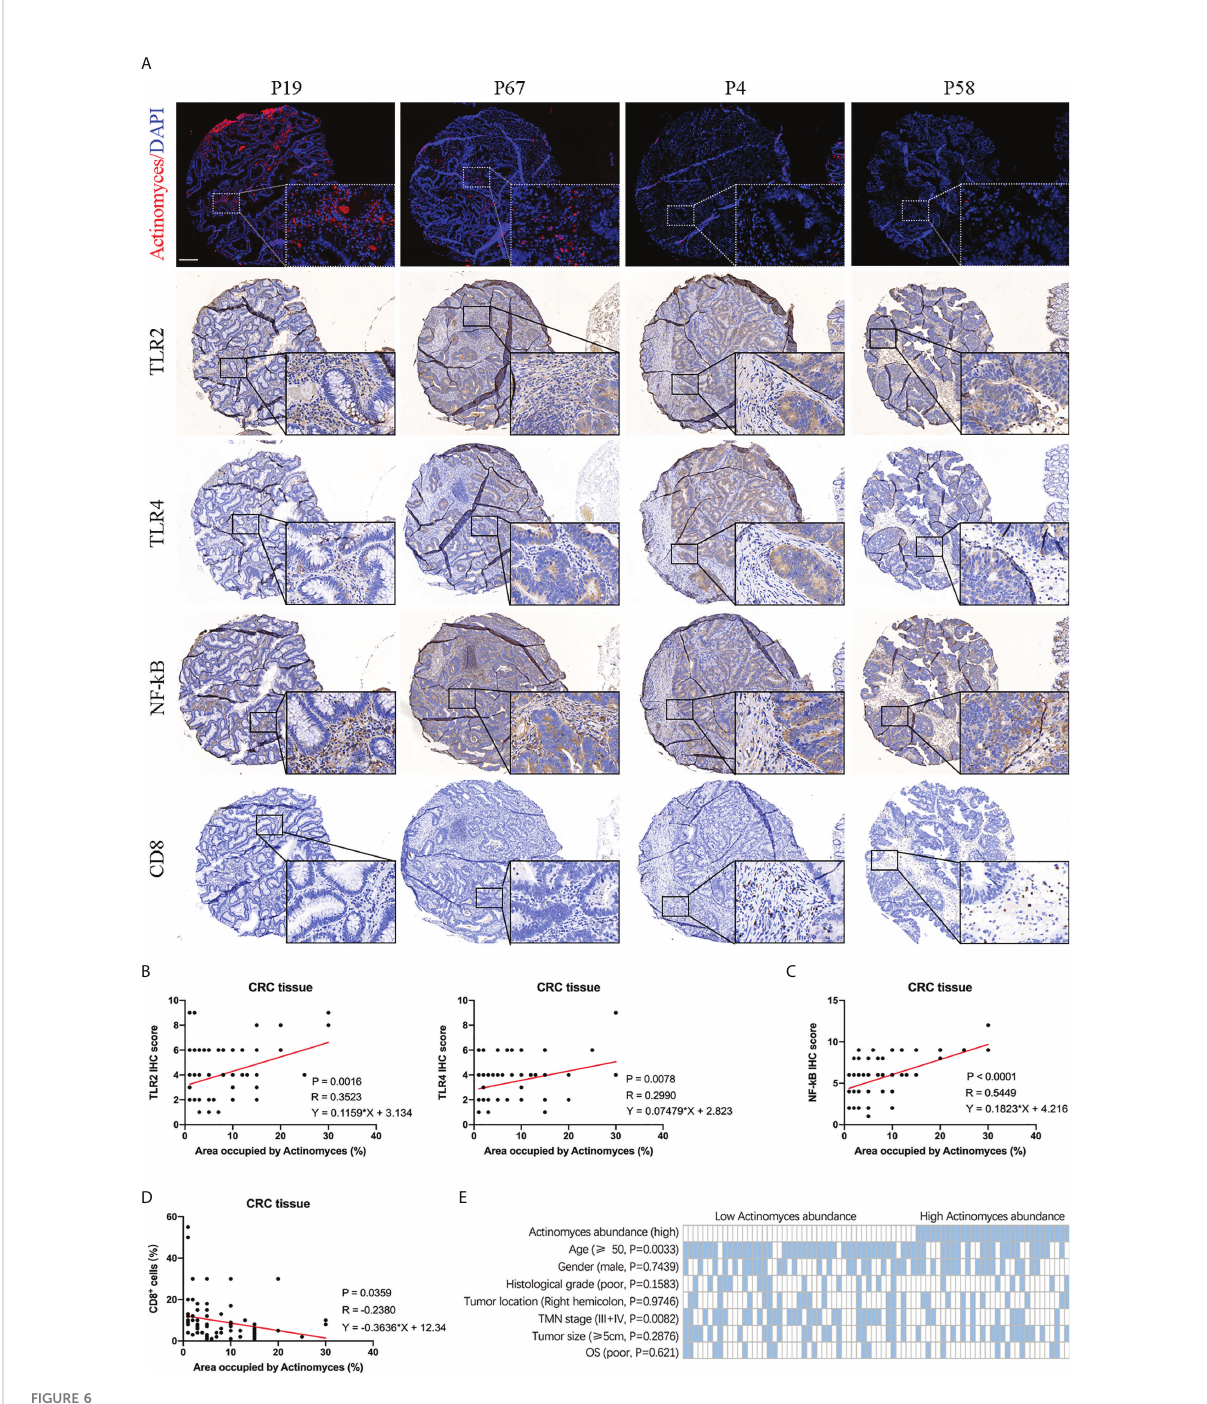
FIGURE 6 Abundance of Actinomyces was associated with TLR2/4 activation and immune cell in fi ltration in CRC. (A) FISH and IHC staining of TLR2, TLR4, NF- k B, and CD8 in human CRC tissues. Scale, 200 m m. (B) Expression of TLR2 and TLR4 were positively correlated with abundance of Actinomyces in CRC tissues. (C) Expression of NF- k B was positively correlated with abundance of Actinomyces in CRC tissues. (D) Proportion of CD8+ cells was negatively correlated with abundance of Actinomyces in CRC tissues. (E) Heatmap shows the clinical characteristics of 78 patients for IHC analysis. Statistical signi fi cance was analyzed by the c 2 test. P values are as